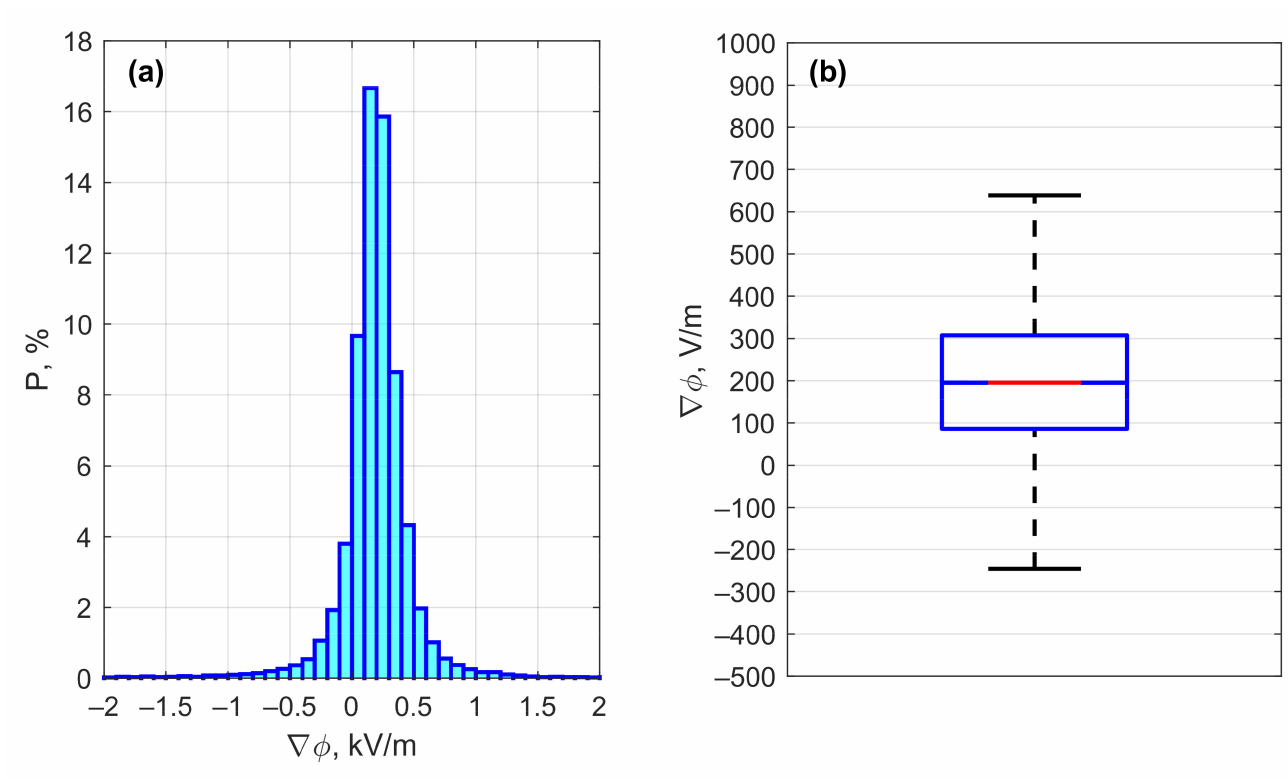
Figure A1. Histogram of the potential gradient values under differentweather conditions for Tomsk ( a ) and the Box Plot quartile diagram ( b ). Table A5. Statistical parameters of the variability in the potential gradient under different weather conditions in Tomsk according to data from the IMCES GO for